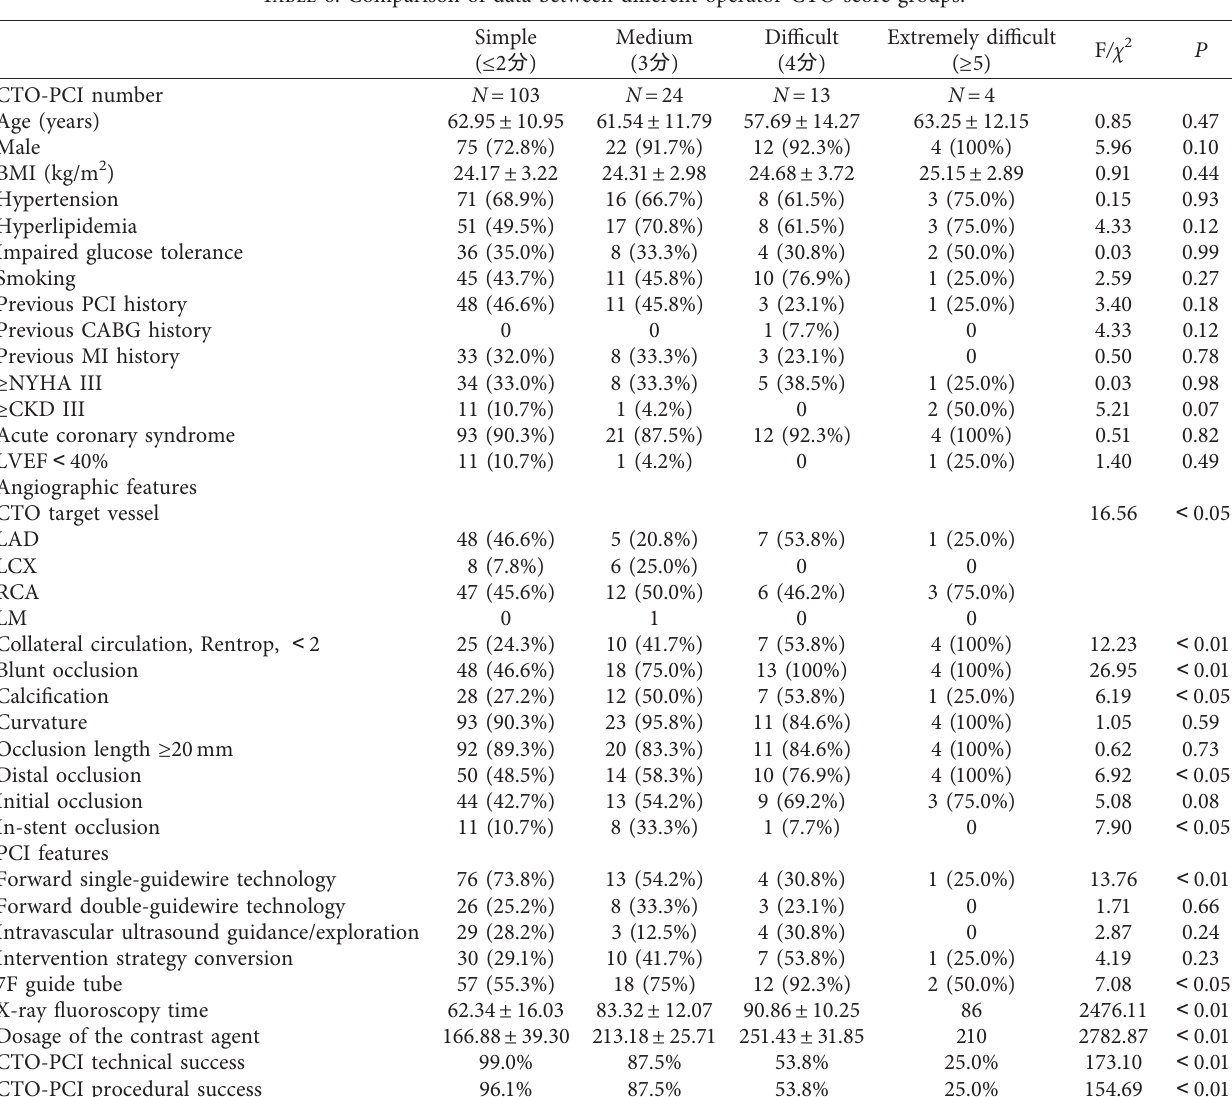
Table 6: Comparison of data between different operator-CTO score